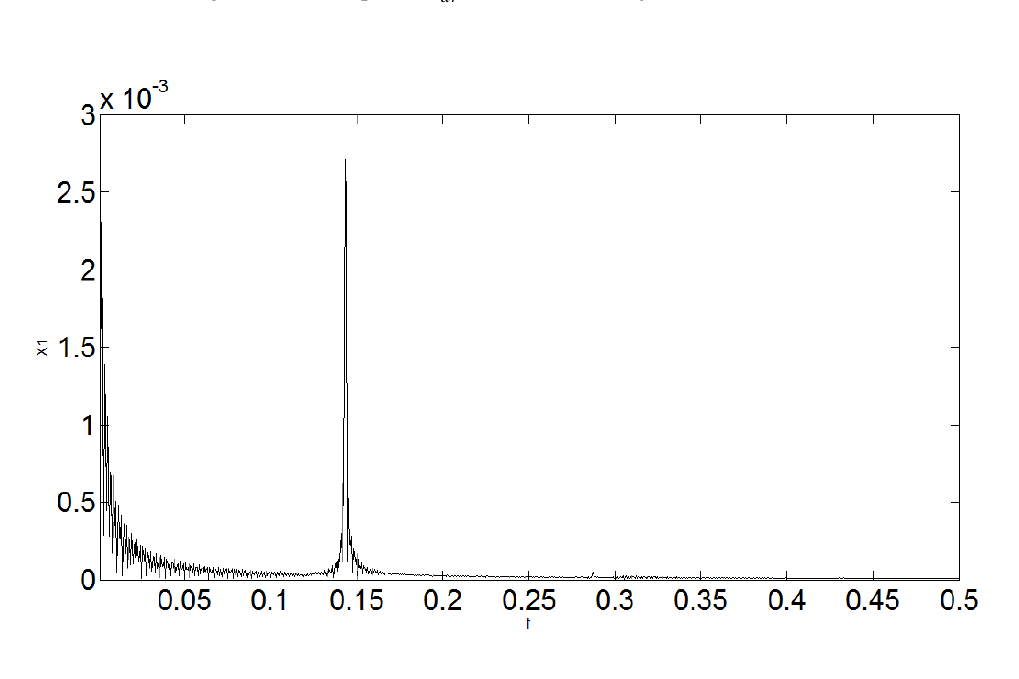
= − 0 . 002788 m ; ξ = 0 . 412; κ = 1 . 5. dr